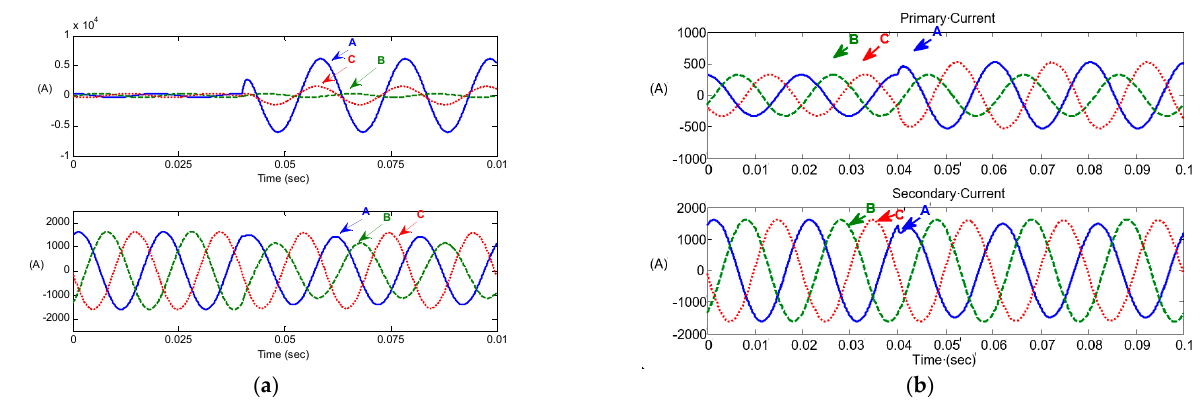
Figure 4. Internal fault simulation’s primary and secondary currents: ( a ) the scenario of a high-voltage winding malfunction; ( b ) the scenario of a low-voltage winding malfunction.